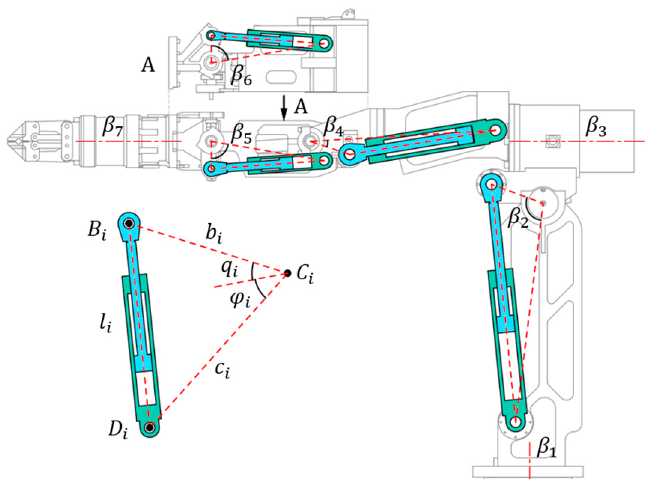
Figure 3. Driving mechanism of the manipulator linear cylinder.